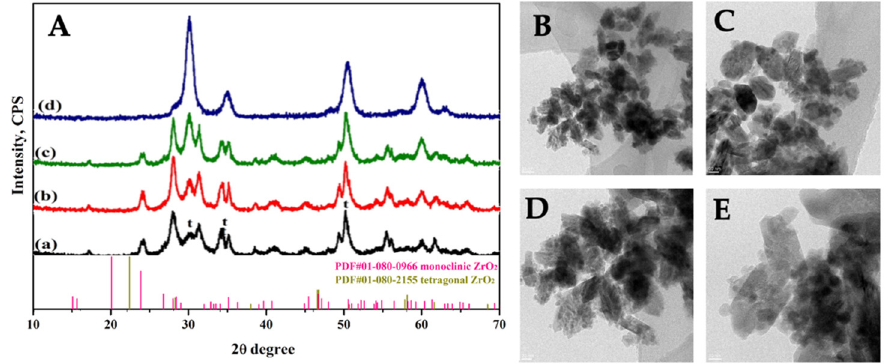
Figure 1. ( A ). XRD patterns of pure ZrO 2 (curve a), ZEY2 (curve b), ZEY5 (curve c), and ZEY10 (curve d) ( B – E ). Representative TEM images of pure ZrO 2 , ZEY2, ZEY5, and ZEY10.